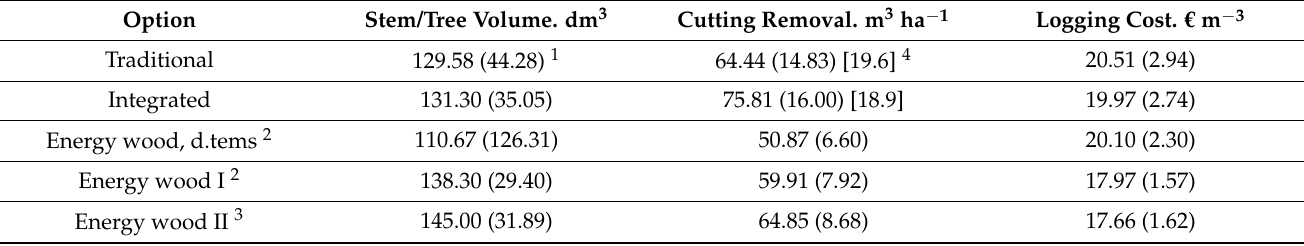
Table 3. Average stem volumes (dm 3 ), cutting removals (m 3 ha − 1 ) and logging costs ( € m − 3 ) associated with the five options for first commercial thinning (FCT) according to stand-level optimization.